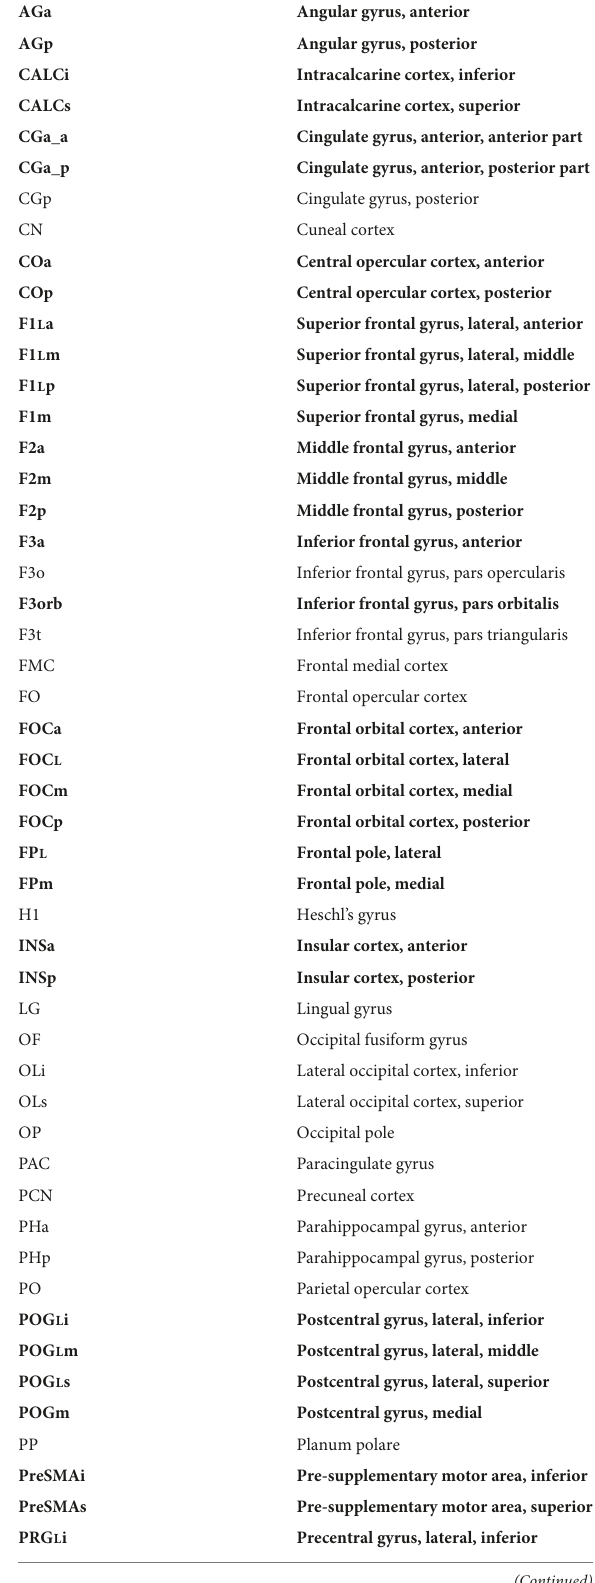
TABLE 1 Parcellation units—Human HOA